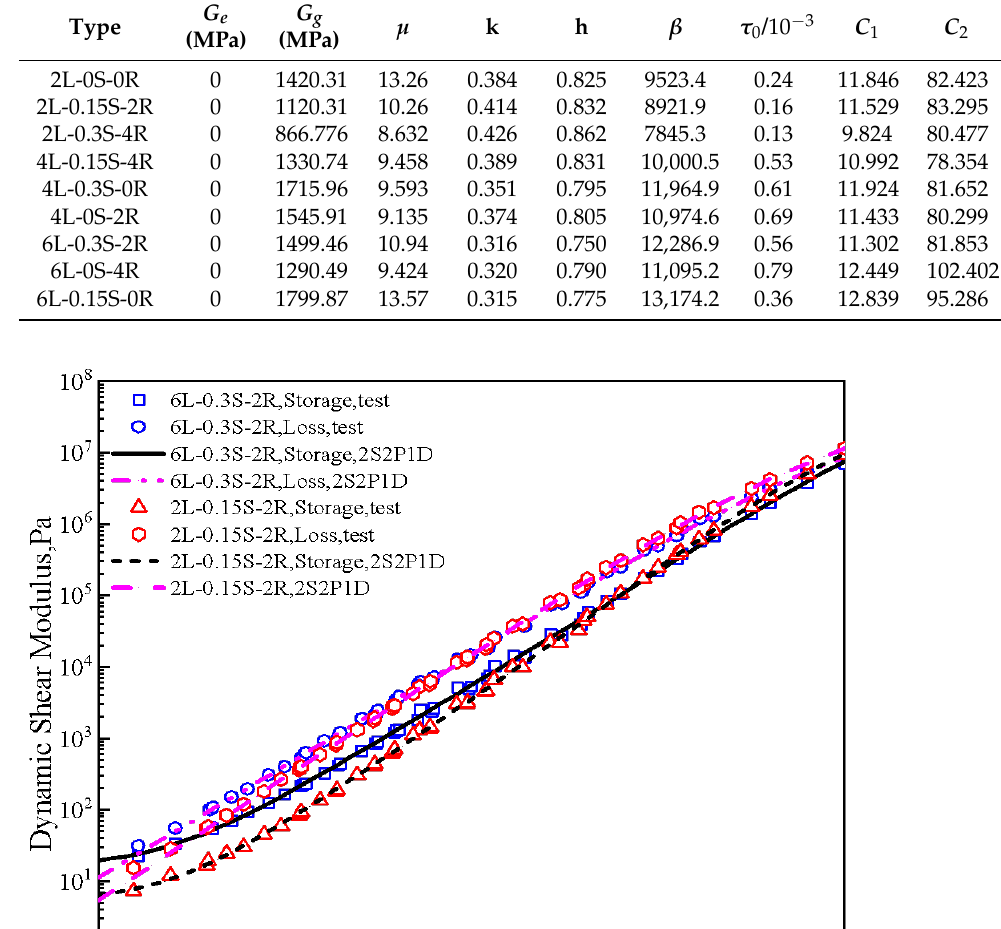
Table 5. The model parameters of all tested binders.